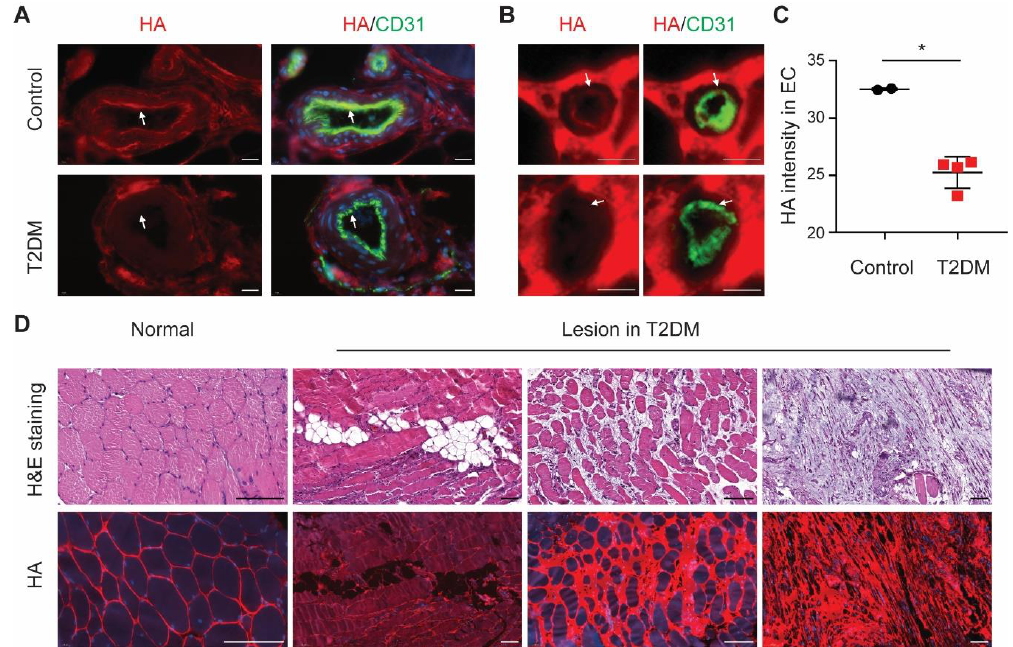
Figure 5. EC hyaluronan decreases in diabetic ischemic muscle. ( A ) Representative images of arteries (scale bar = 20 µm) and ( B ) small capillaries (scale bar = 5 µm) in ischemic muscle of type 2 diabetic patients with critical limb ischemia ( n = 4) and control ( n = 2), stained with the HA binding probe Ncan-dsRed (red) and CD31 (green) for endothelial localization. ( C ) Quantification of HA intensity colocalized with CD31 in ECs. ( D ) Representative images of H&E staining (top row) and HA staining (bottom row) in the normal and lesion area of ischemic muscle of type 2 diabetic foot patients ( n = 4, scale bar = 100 µm). Values are given as mean ± SD. * p < 0.05.